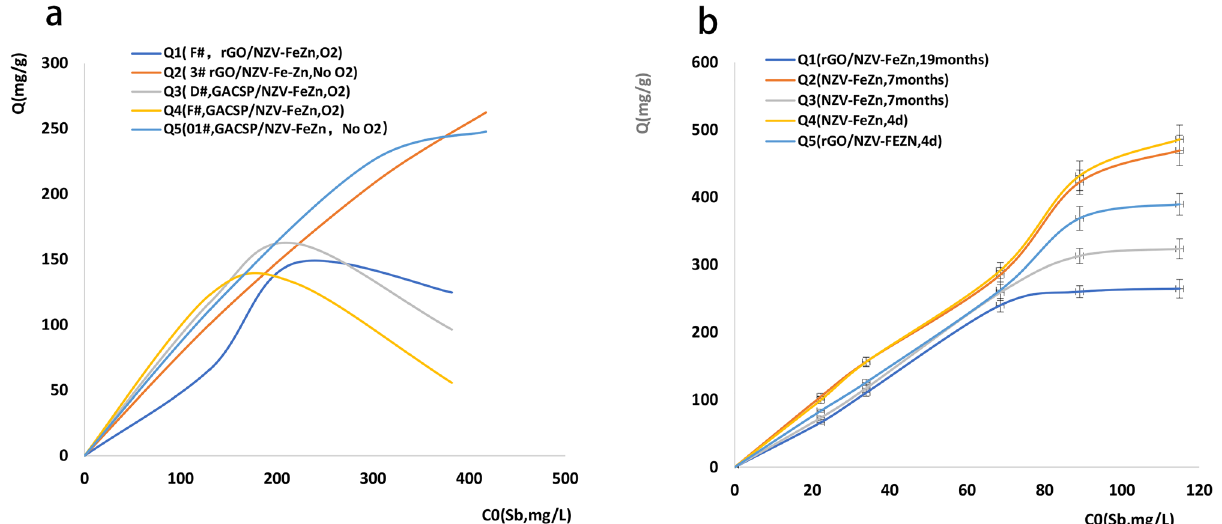
Figure 5. Effects of storage time, temperature, and sunlight on the Sb(V) removal performance of the selected adsorbents. Results obtained for ( a ) room temperature (20 °C), no sunlight, loading = 0.05 or 0.1 g L −1 , adsorbent = NZV-FeZn or rGO/NZV-FeZn; ( b ) room temperature (20 °C), sunlight (measured temperature = 26 °C), loading = 0.1 g L −1 , adsorbent = rGO/NZV-FeZn (2018042803) stored for 19 months (1#), NZV-FeZn (2019042801) stored for 7 months (2#), rGO/NZV-FeZn (2019042803) stored for 7 months (3#), freshly synthesised (4 days) NZV-FeZn (2019111401) (4#), and freshly synthesised (4 days) rGO/NZV-FeZn (2019111402)